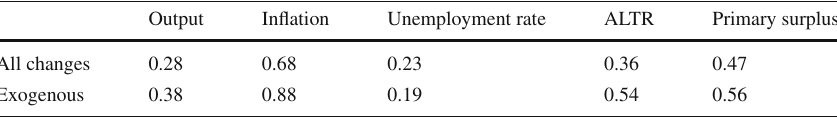
Table 1 Predictability